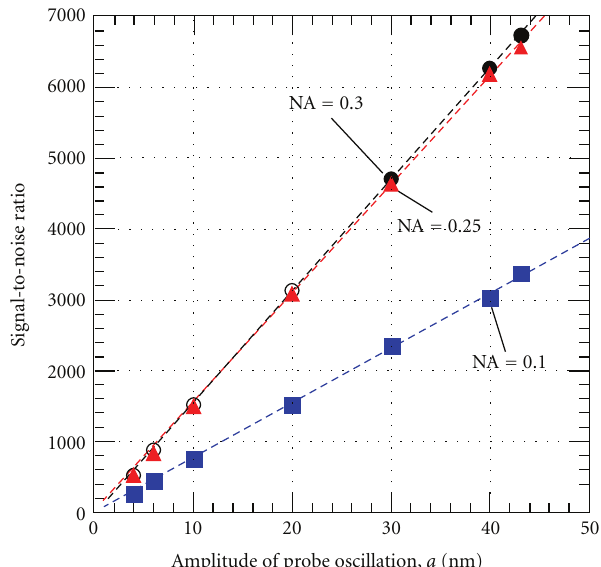
Figure 3: Experimental results of the measured relationship between the probe oscillation amplitude and the signal-to-noise ratio of the displacement